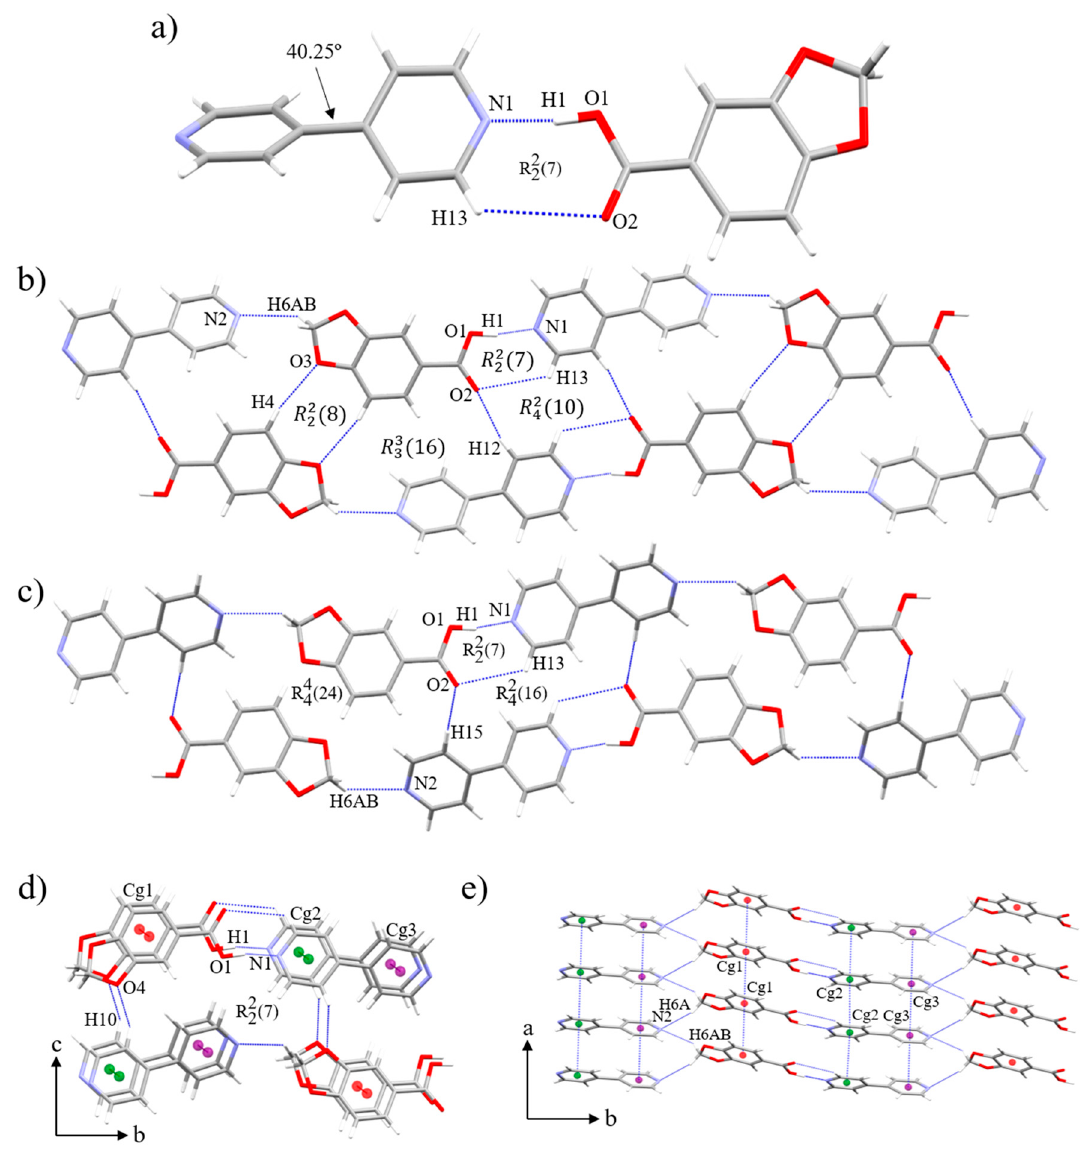
Figure 1. ( a ) Structure of cocrystal (HPip)(4,4’-bpy) ( 1 ). ( b ) Chain 1 and ( c ) chain 2 of cocrystal 1 , both expanding along the [1 (cid:3364) 10] and [110] directions. ( d ) General view along the bc plane of the C10-H10···O4 which expands the structure through the c axis. ( e ) General view of the C-H···N and π ··· π interactions of cocrystal 1 along the ab plane.